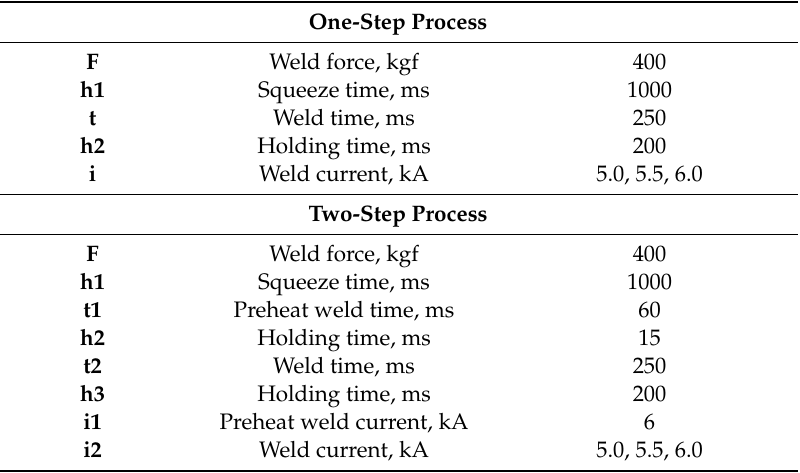
Figure 2. RSW schedules: ( a ) One-step; ( b ) two-step. Table 2. Welding process parameters for resistance spot welding (RSW) scheme.